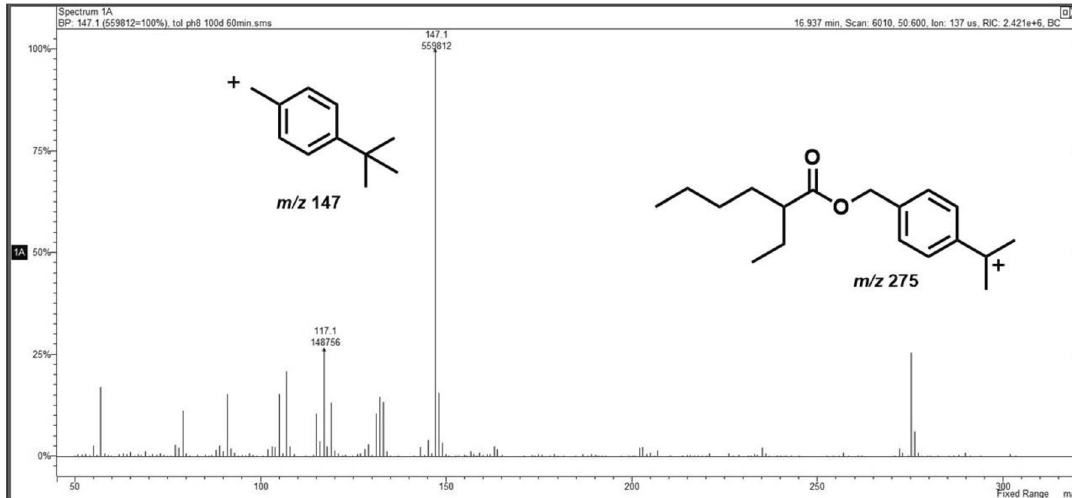
Fig. 5 The EI mass spectrum of 4- t -butylbenzyl 2-ethylhexanoate (MW